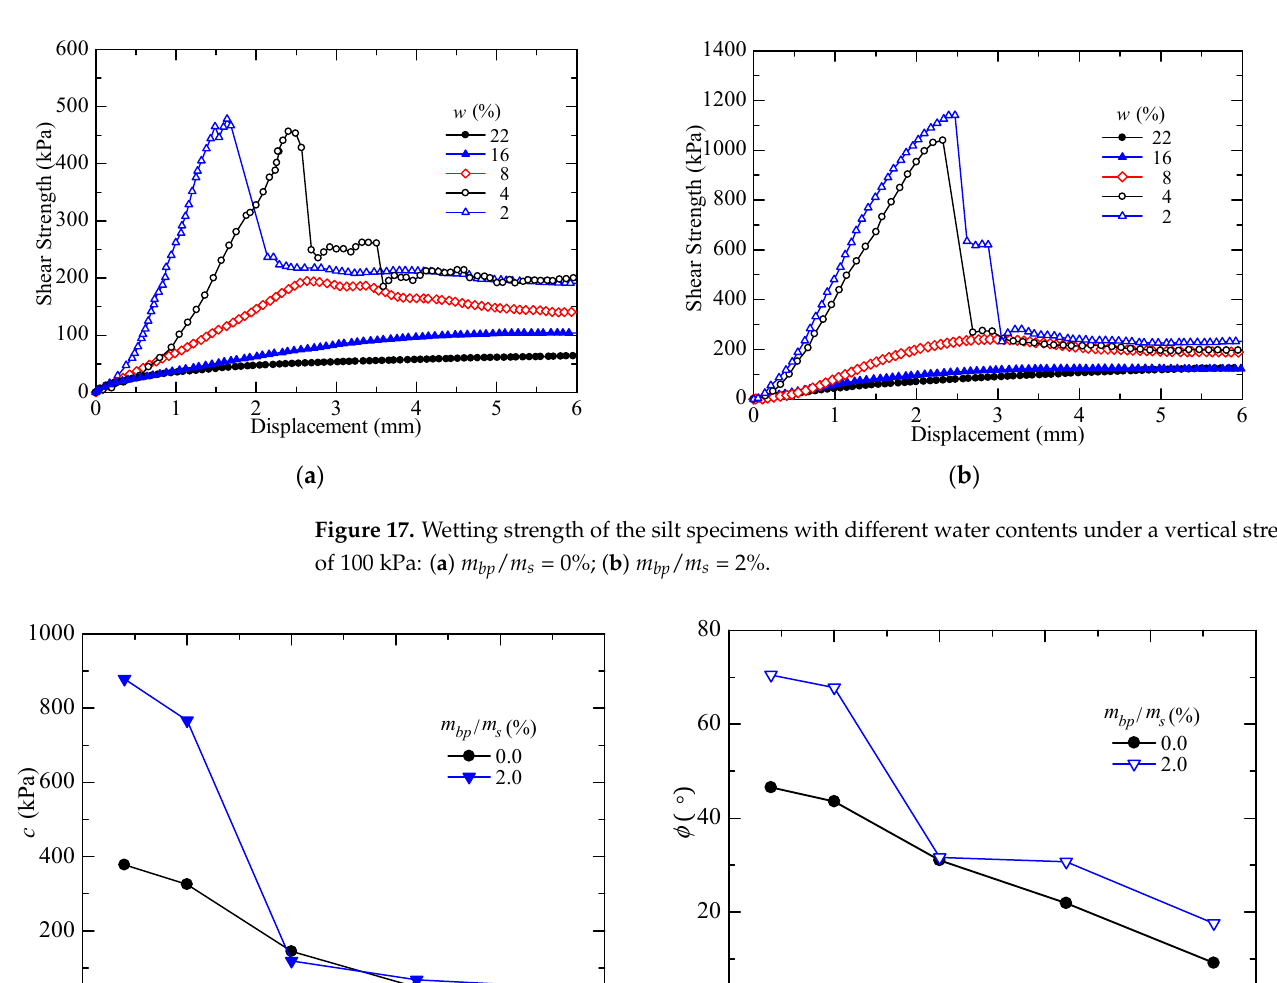
Figure 17. Wetting strength of the silt specimens with different water contents under a vertical stress of 100 kPa: ( a ) m bp / m s = 0%; ( b ) m bp / m s = 2%.